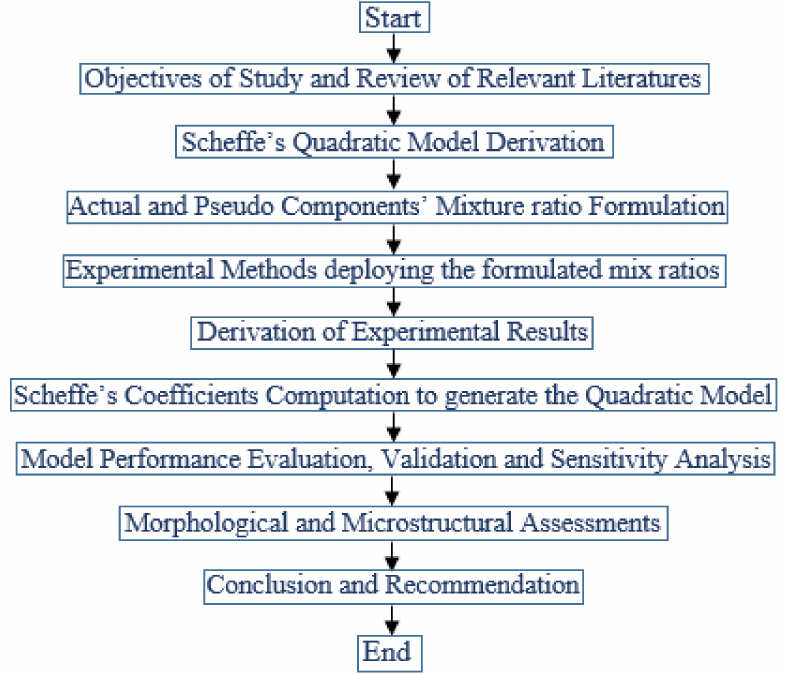
Figure 1. Scheffe’s model development flow chart methodology (source: Attah et al.